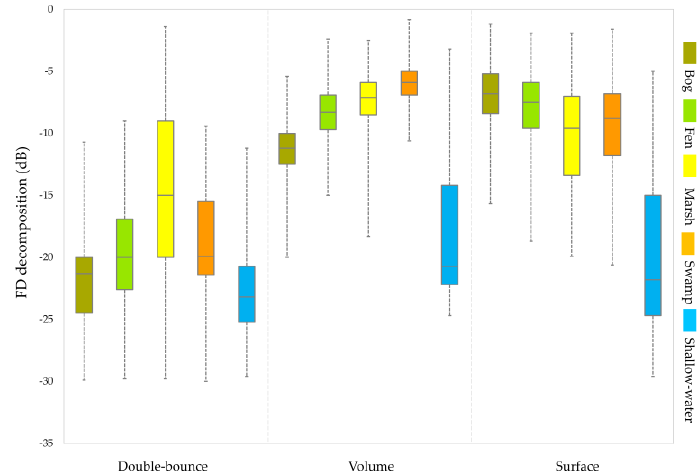
Figure 4. Box-and-whisker plots for extracted features from the Freeman-Durden decomposition for wetland classes obtained from the pixel values of the training data set.